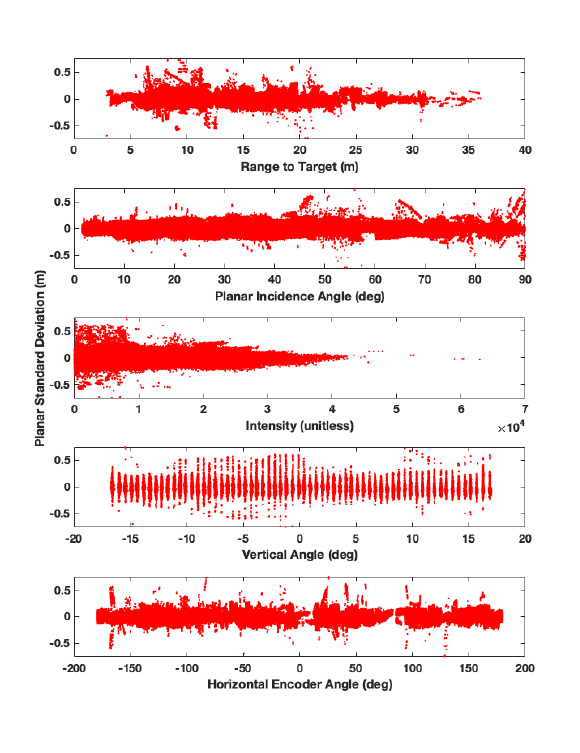
Figure 8. Ouster OSI-64 Planar Residuals Plotted Versus Range, Incidence Angle, Intensity, Horizontal Angle and Vertical